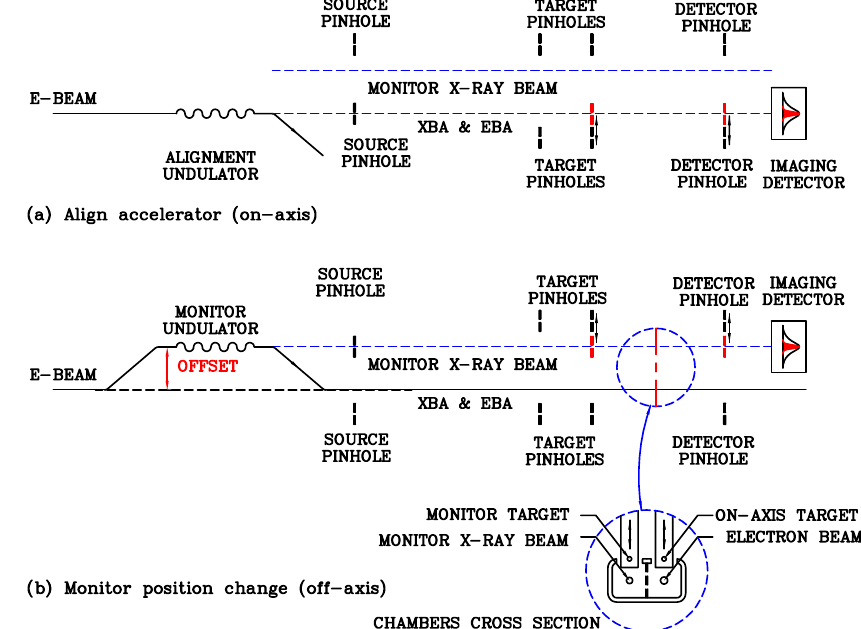
FIG. 11. (Color) Real-time position monitoring system: (a) Alignment with on-axis trajectory and targets. (b) Observe position changes with off-axis monitoring x-ray beam line. The inset shows two independently retractable pinhole targets, one used for XBA and the other for monitoring position changes. In an x-ray FEL, the monitoring beam line has its own vacuum chamber to reduce the radiation